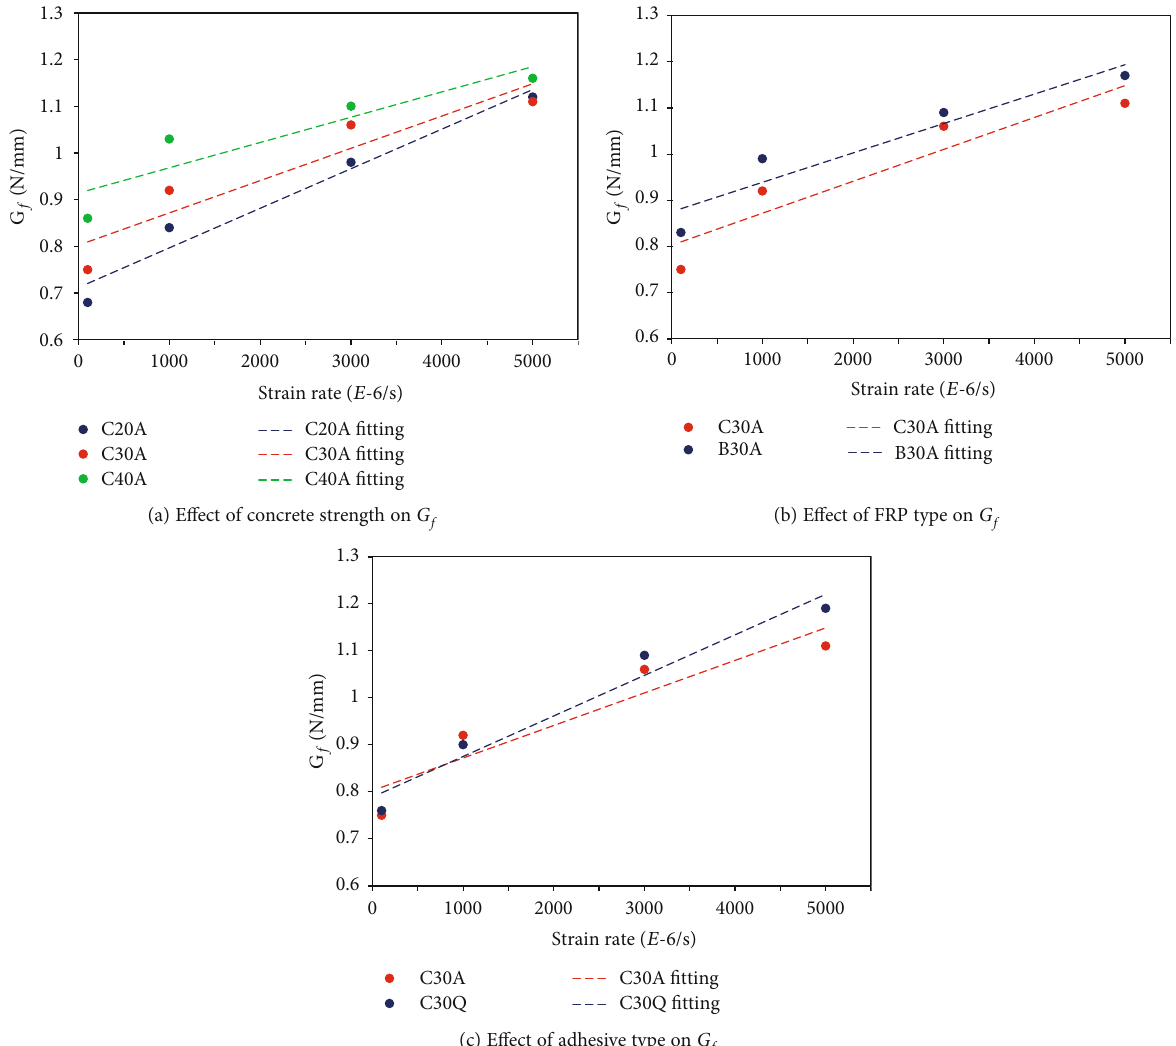
Figure 4: E ff ect of material properties on G